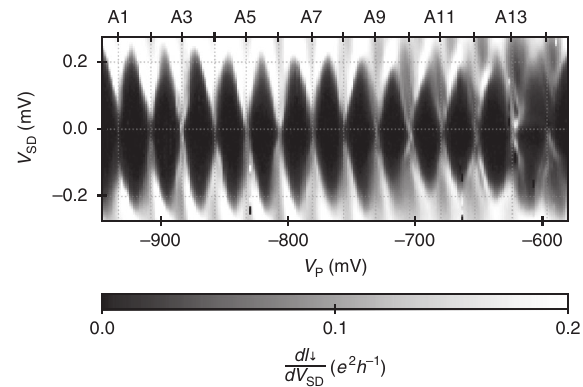
Fig. 3 Coulomb diamonds. Transconductance measurement as the bias voltage, V SD , and the plunger gate voltage, V P , are swept. The investigated resonances, A1 – A14, occurring in the swept V P interval are labelled at the upper